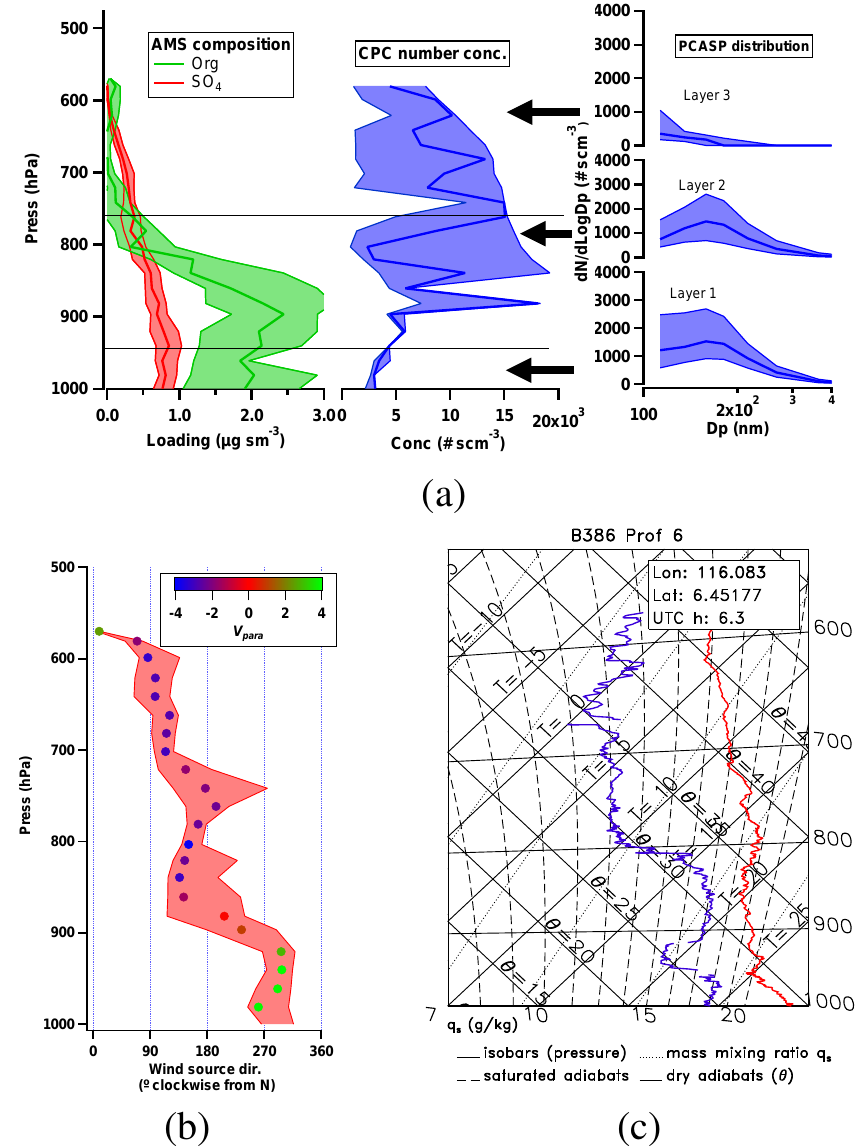
Fig. 12. Average altitude profile (median and interquartile ranges) during the ITC-dominated regime over Kota Kinabalu on the west coast of Borneo of (a) organic and sulphate aerosol loading, number concentration and number size distributions for each layer and (b) wind direction, coloured by component of direction parallel to the onshore wind, V para , (i.e. positive values onshore and negative offshore) to emphasise the sea-breeze wind shear. Averages comprised nine profiles from 11 July 2008, 13 July 2008 and 14 July 2008. (c) shows an example tephigram.